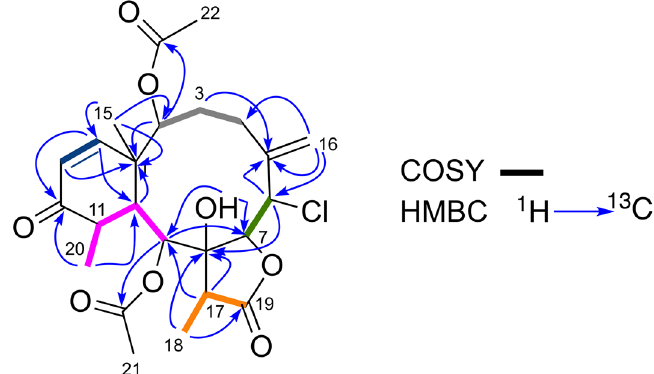
Figure 2. 1 H- 1 H COSY and key HMBC correlations found in 1. Figure was created with Chemdraw V.20 (see permission in https ://infor matic s.perki nelme r.com/sites ubscr iptio